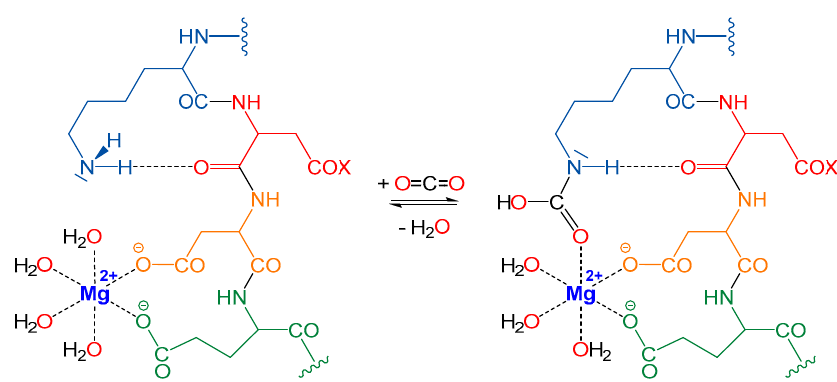
Figure 1. CO 2 capture in the active site of rubisco.